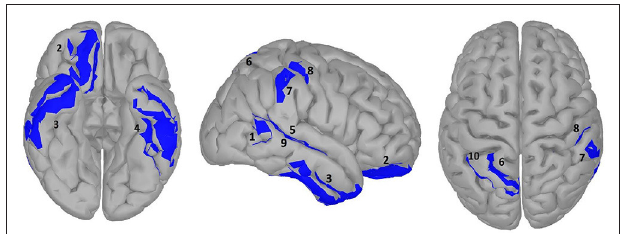
FIGURE 5 | significance map for abstractness.